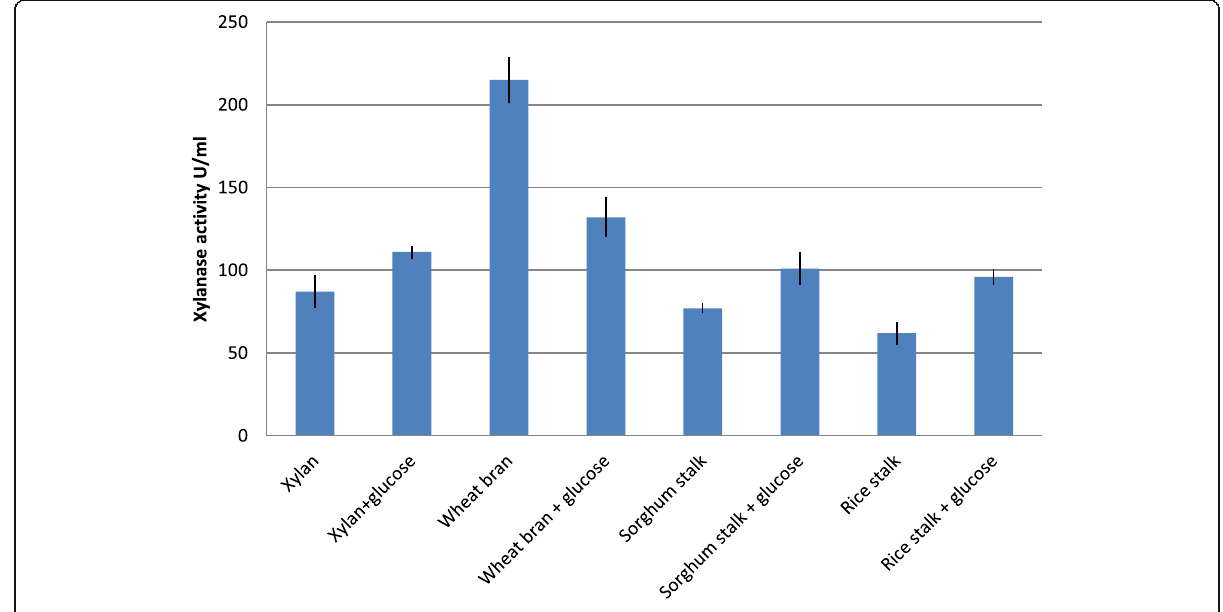
Fig. 2 Effect of different carbon sources on xylanase production